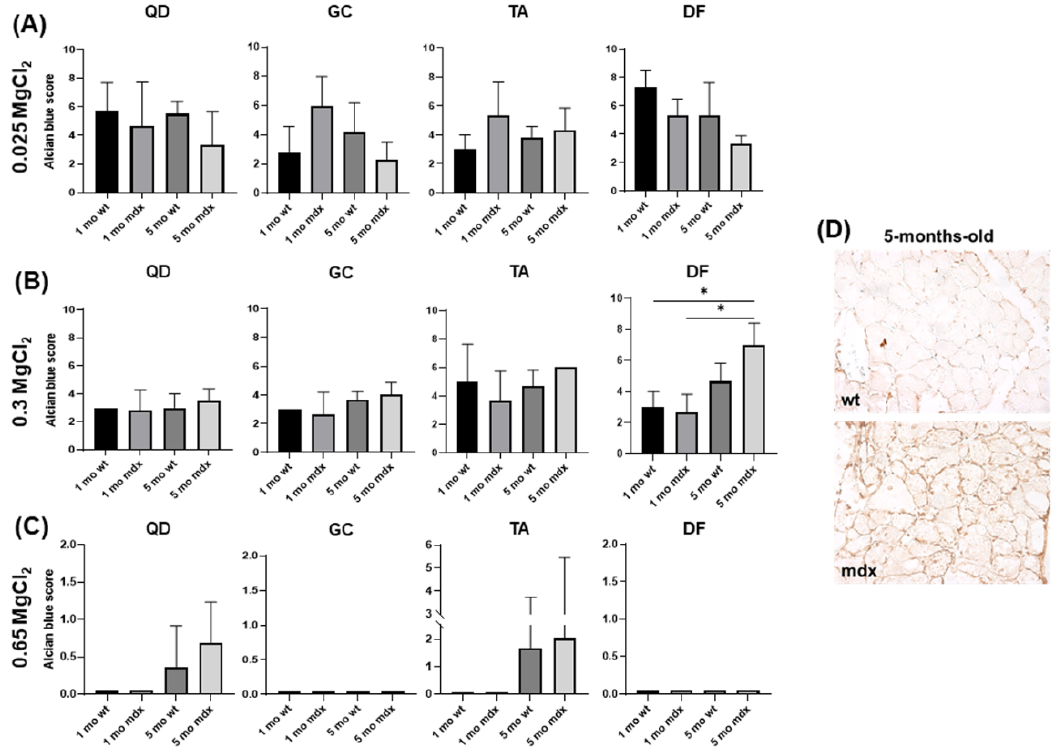
Figure 7. Representative bar graphs showing the score indicating GAG/PG abundance in the differ- ent muscles of young and adult wt and mdx mice after staining with Alcian blue containing 0.025 MgCl 2 ( A ), 0.3 MgCl 2 ( B ), and 0.65 MgCl 2 ( C ). Data are mean ± SD. * p < 0.05. ( D ) Representative micrograph showing BYG immunoreactivity localisation close and around skeletal myofibres. Orig- inal magnification: 40×.